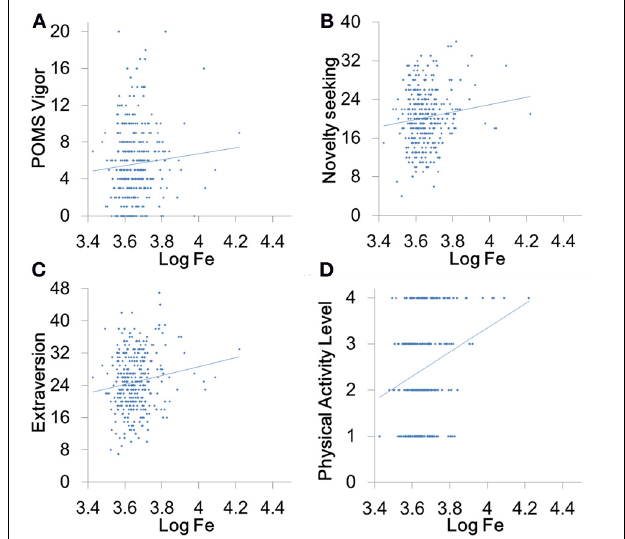
FIGURE 3 | Associations between hair iron levels and psychological variables related to creativity. (A) A scatterplot comparing POMS Vigor subscale score and the logarithms of hair iron levels, which shows a nonsignificant association. (B) A scatterplot comparing Novelty Seeking scale score and the logarithms of hair iron levels, which shows significant positive associations. (C) A scatterplot comparing Extraversion scale score and the logarithms of hair iron levels, which shows significant positive associations. (D) A scatterplot comparing the physical activity level and the logarithms of hair iron levels, which shows significant positive